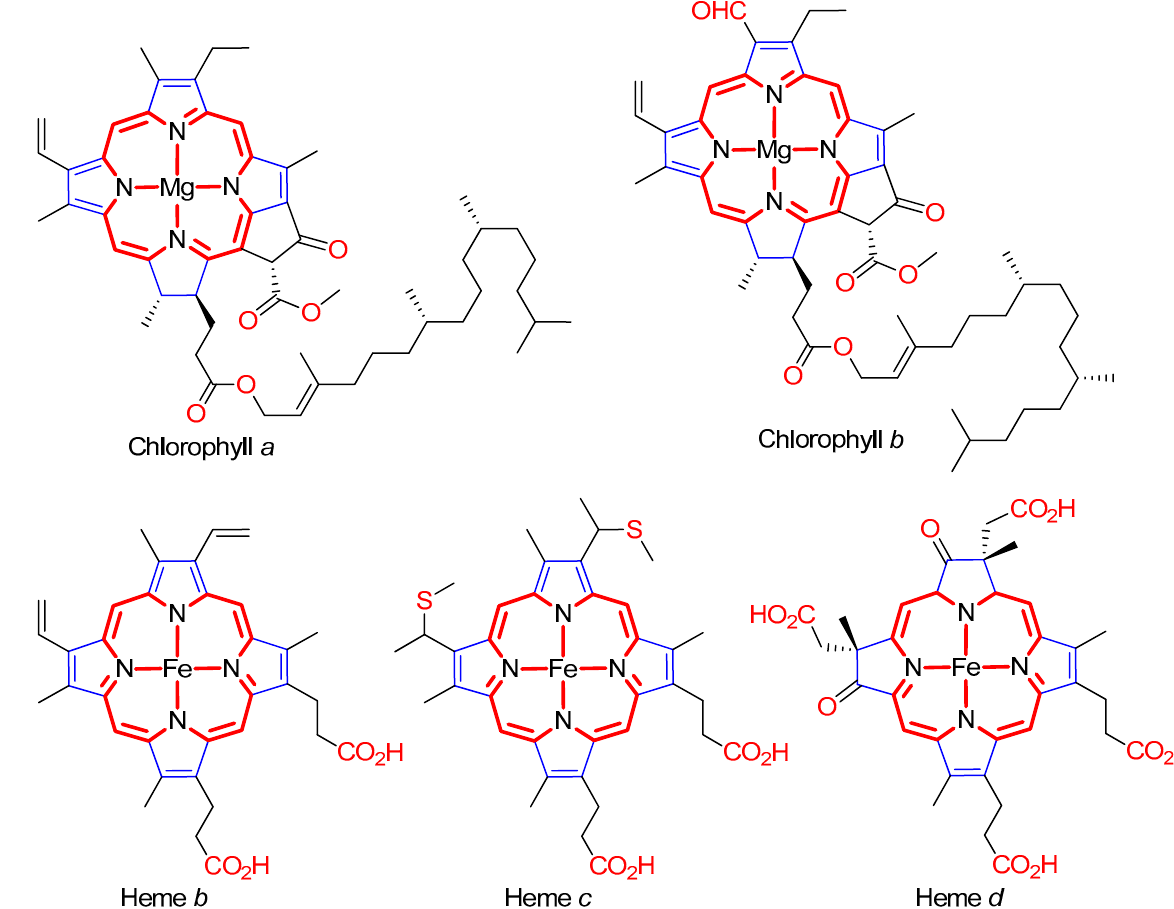
Figure 1. Structures of some metalloporphyrins which demonstrates the life on earth.